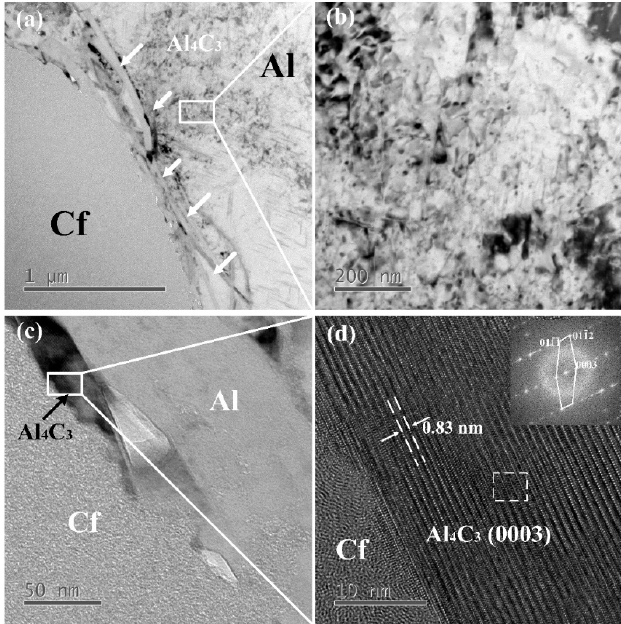
Figure 4. ( a ) Bright-field transmission electron microscopy (TEM) morphologies of the fiber/matrix interface in the SCFs/2024 Al composites, ( b ) enlarged view of the dislocation accumulation in the matrix, ( c ) enlarged view of the Al 4 C 3 embedding at the interface and ( d ) corresponding HRTEM image of the selected area in Figure